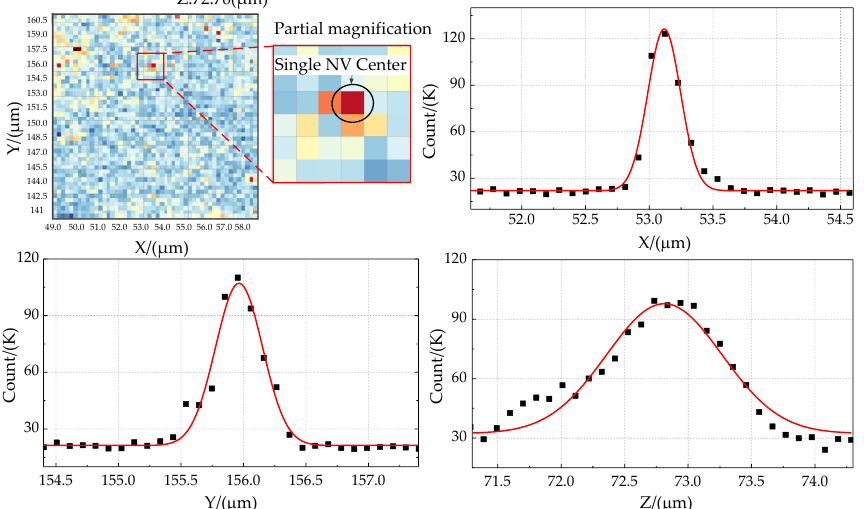
Figure 23. Characterization of the diamond sample with the NV center and its X, Y, and Z-axis fluorescence scanning curve.